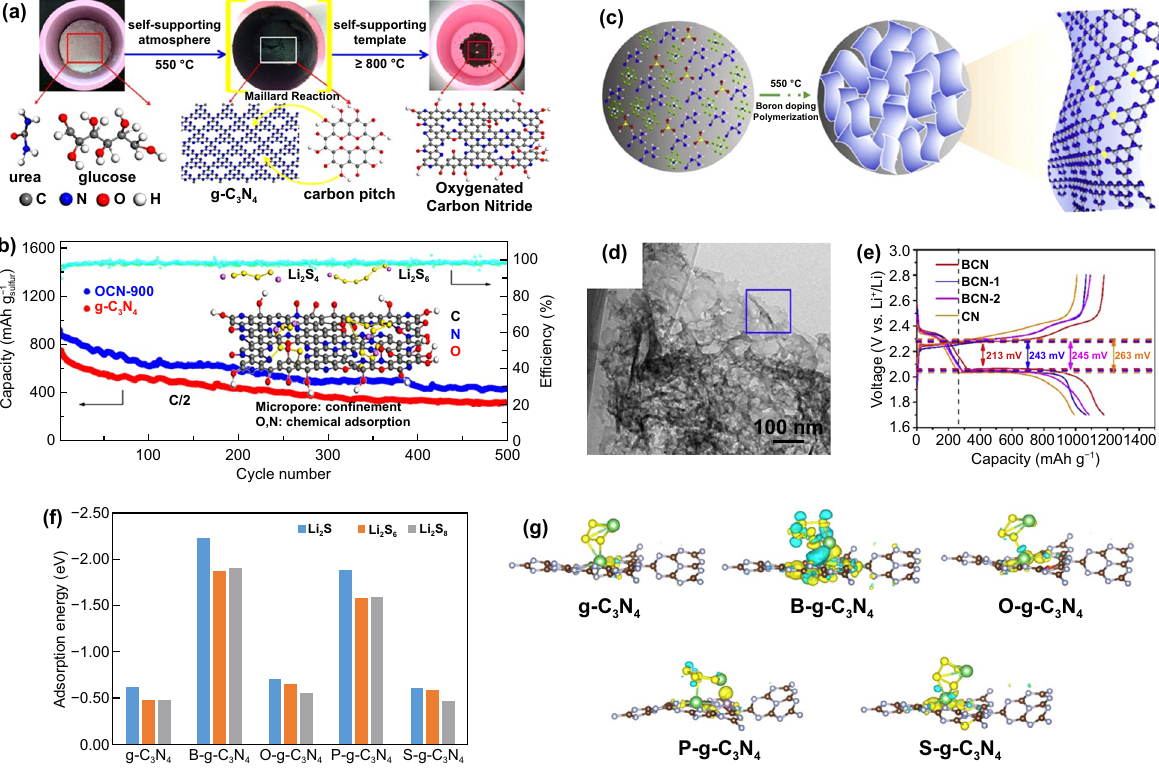
Fig. 5 a Schematic illustration of the preparation process and structure of OCN. b Cycling performance of cells with g‑C 3 N 4 and OCN‑900 as sulfur hosts at 0.5 C [80]. Copyright 2015, American Chemical Society. c Schematic illustration of the preparation process and structure of BCN. d STEM image of BCN. e Charge–discharge voltage profiles of cells with different modified separators [81]. Copyright 2020, Elsevier. f Adsorption energies for